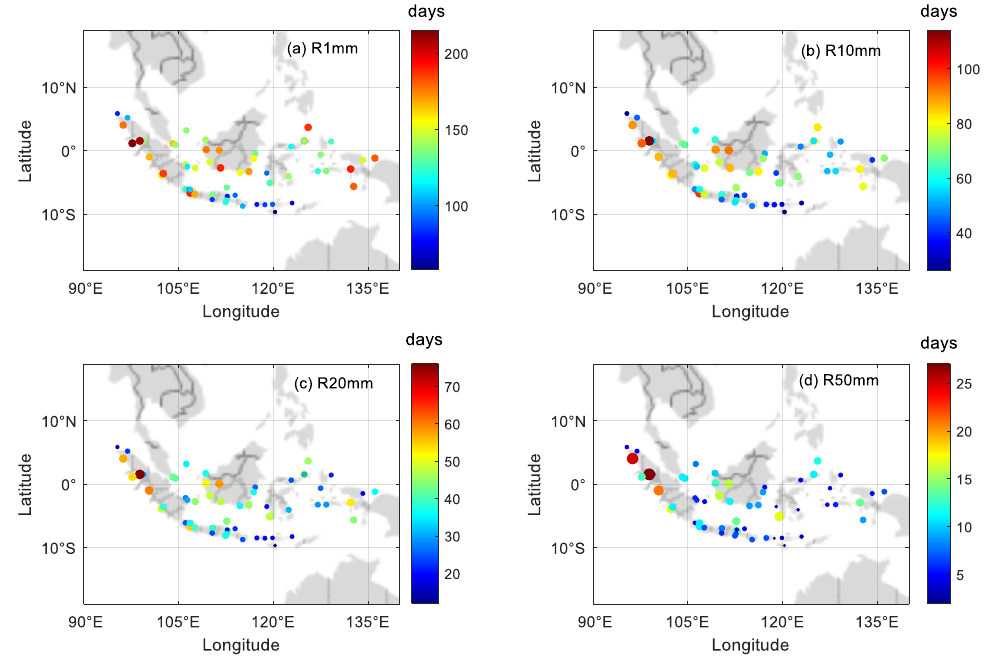
Figure 7. The mean value of precipitation-frequency-based indices including R1mm ( a ), R10mm ( b ), R20mm ( c ) and R50mm ( d ), for 63 of BMKG stations in the IMC during 2016 to 2020.